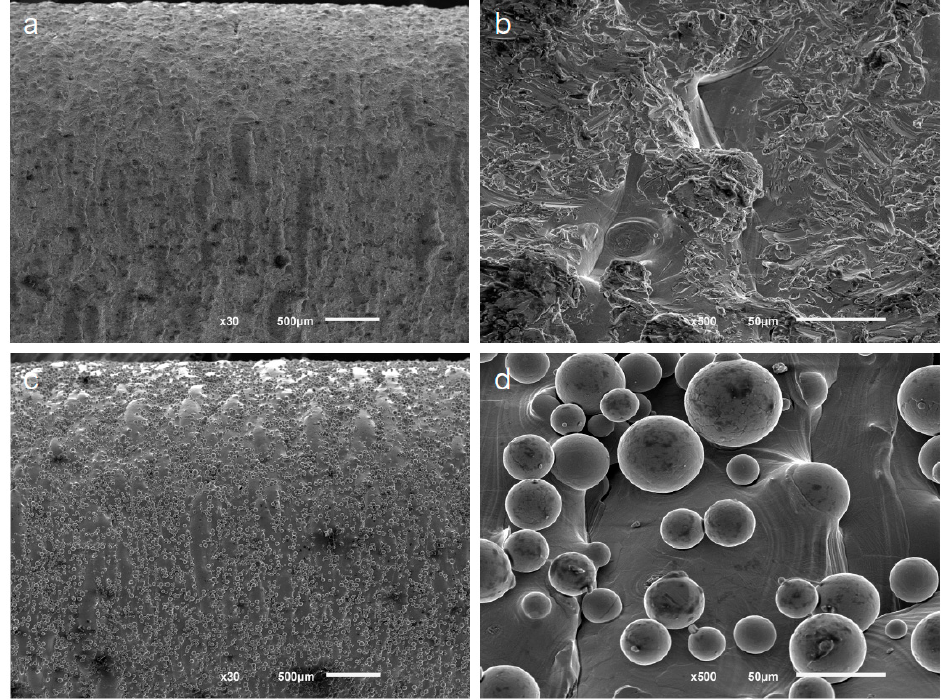
Figure 9. SEM images of the surface of small samples. New powder resulted in smoother surfaces and some defects can be observed ( a , b ). Recycled powder resulted in many partially melted powder particles adhered to the surface, creating a rough surface ( c , d